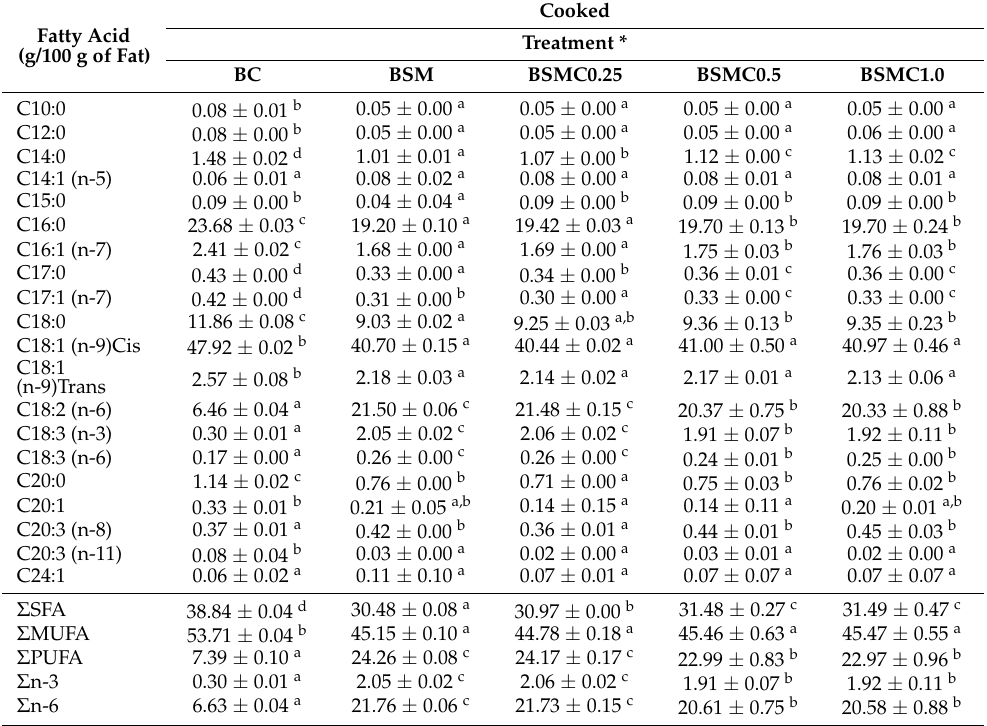
Table 5. Effect of partial replacement of pork backfat with a gelled emulsion of maca flour, soybean oil, and chincho essential oil on the fatty acid profile of cooked beef